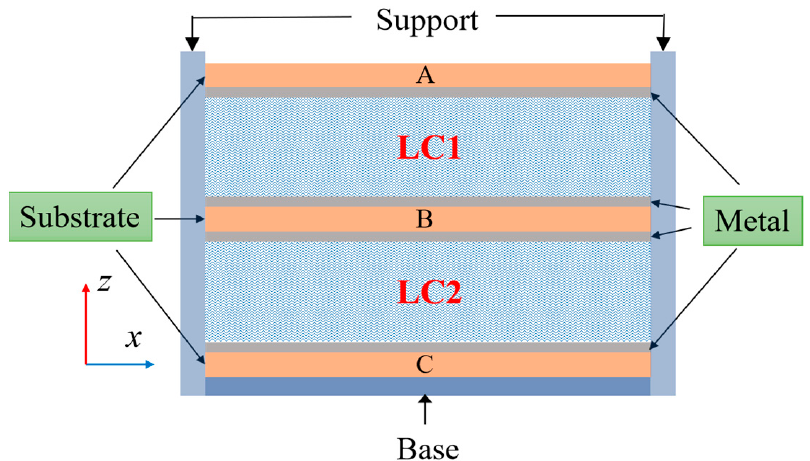
Figure 1. Schematic diagram of the LC dual-tuned mode structure.